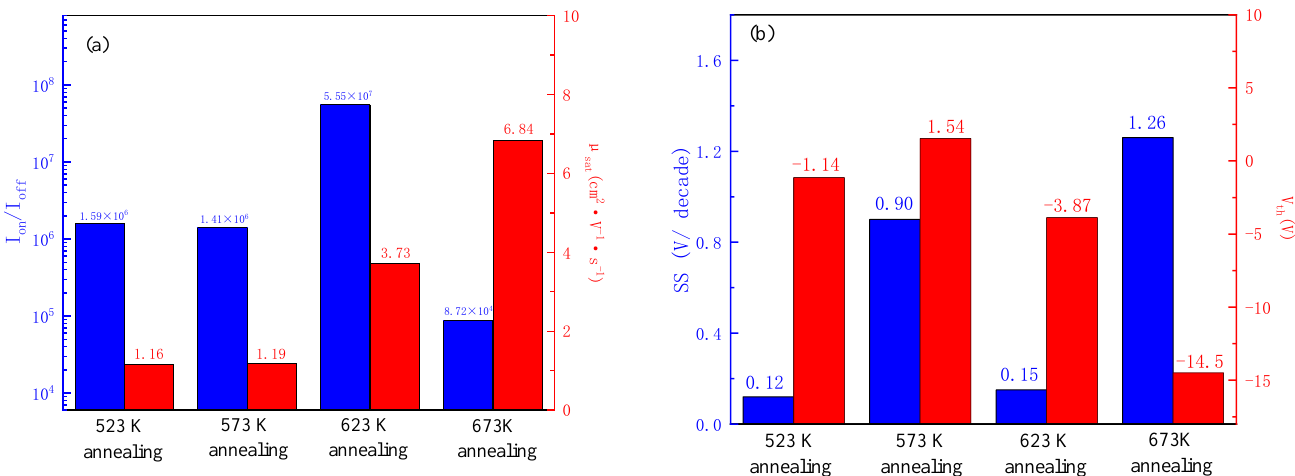
Figure 9. Main device performance of TFTs at different annealing temperatures: ( a ) I on /I off and μ sat , and ( b ) SS and V th .